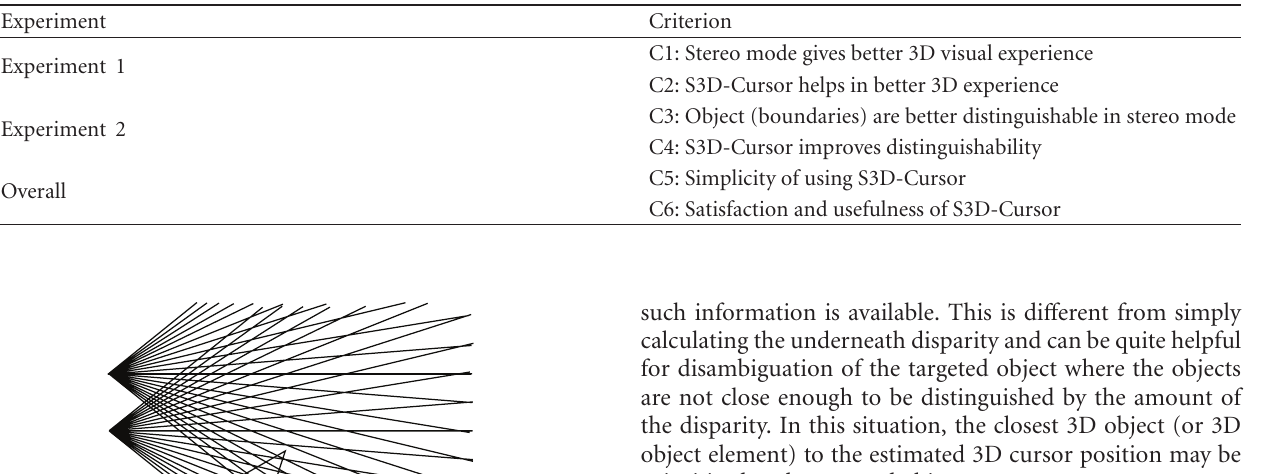
Table 2: S3D-Cursor user evaluation criteria.